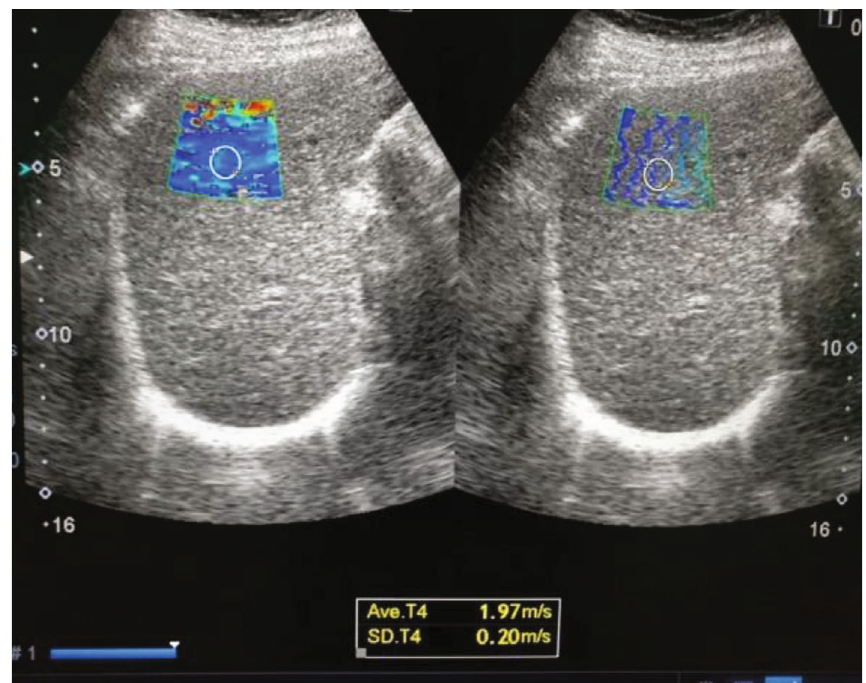
Figure 3: Di ff use hepatic parenchymal disease with F3 METAVIR score expressed as shear wave velocity (1.97